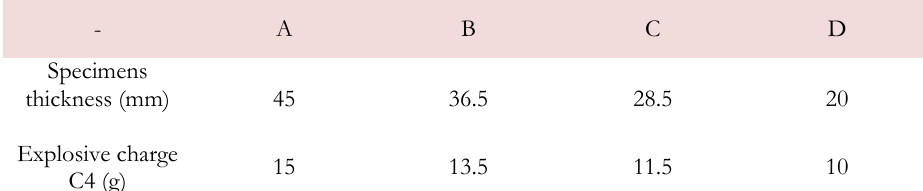
Table 12: The values for numerical